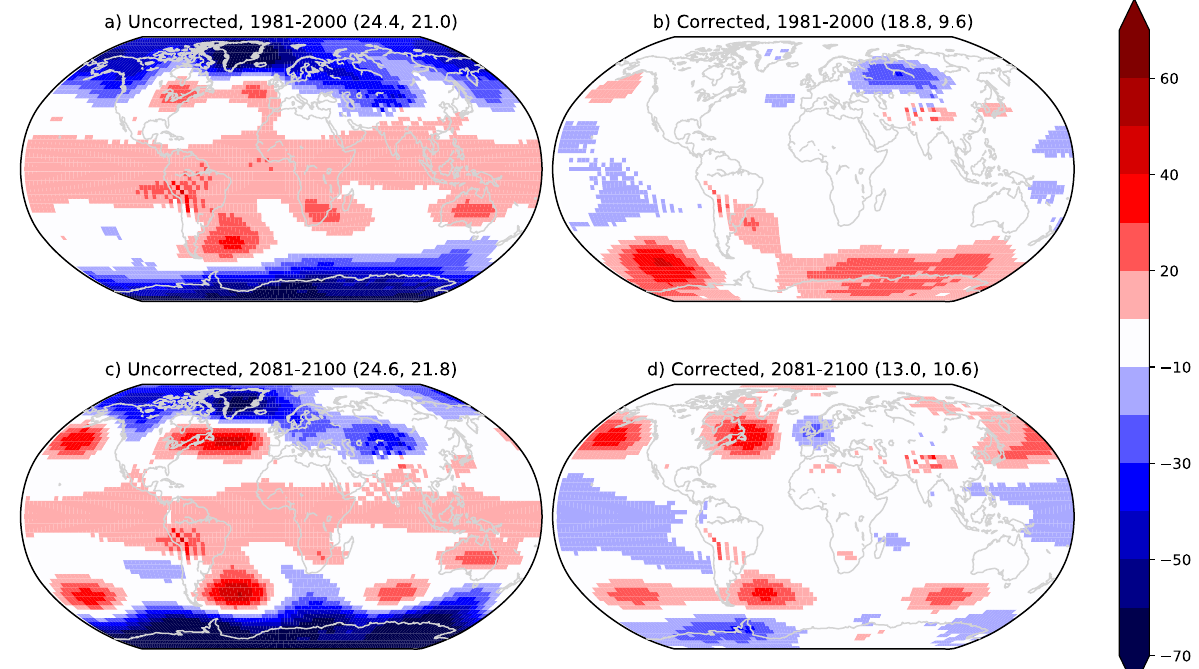
Fig. 2 Mid-tropospheric geopotential height errors. Annual mean 500 hPa geopotential height difference (in m ) between CanAM and CNRM-CM. a Uncorrected, 1981 – 2000; b corrected, 1981 – 2000; c uncorrected, 2081 – 2100; d corrected, 2081 – 2100. The global mean error is subtracted to highlight the spatial structures over global mean errors. RMSE of the CanAM4 simulation with respect to the CNRM reference (in m ), before and after subtraction of the global mean error, is given in parentheses in the panel titles.